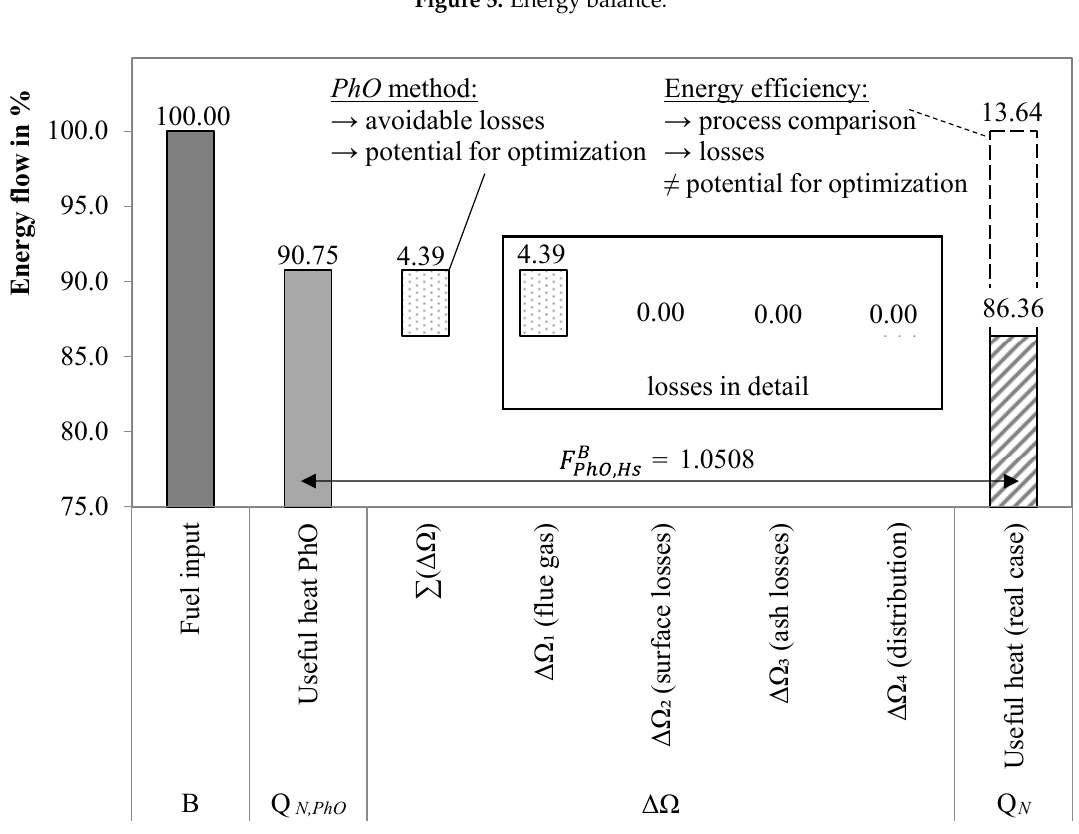
Figure 5. Energy balance.